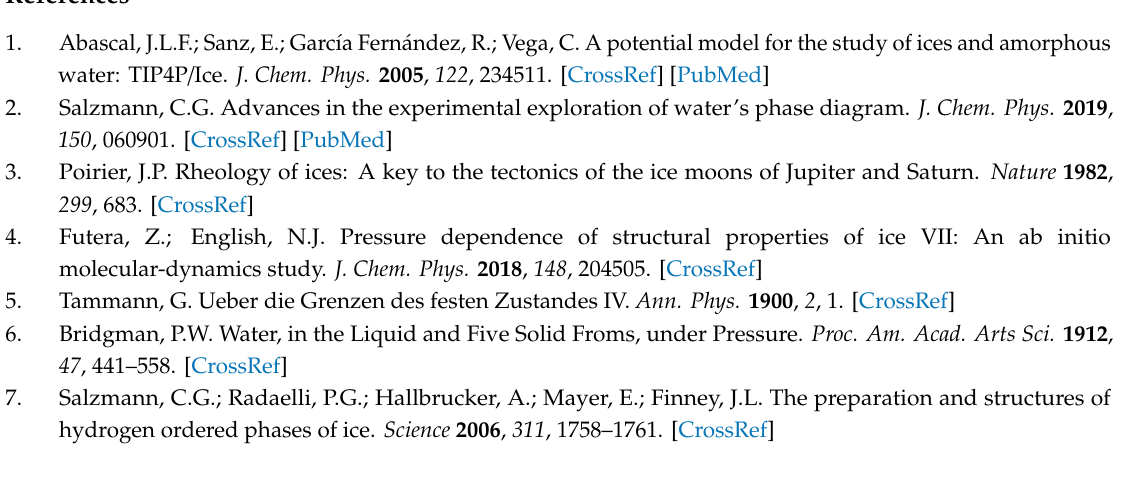
Figure S1: Density-Functional Theory (DFT) (PBE-D3 and PBE-MBD)-predicted energy against TIP4P energy. Figure S2: DFT (PBE-dDsC) predicted energy against TIP4P energy. Table S1: Comparison between TIP4P- and DFT-Predicted Ten Lowest-Enthalpy-per-Molecule Structures at 0 bar. Table S2: Comparison between TIP4P- and DFT-Predicted Ten Lowest-Enthalpy-per-Molecule Structures at 4000 bar. Table S3: Comparison between TIP4P- and DFT-Predicted Ten Lowest-Enthalpy-per-Molecule Structures at 8000 bar. Table S4: Comparison between TIP4P- and DFT-Predicted Densities at 0 bar. Table S5: Comparison between TIP4P- and DFT-Predicted Densities at 4000 bar. Table S6: Comparison between TIP4P- and DFT-Predicted Densities at 8000